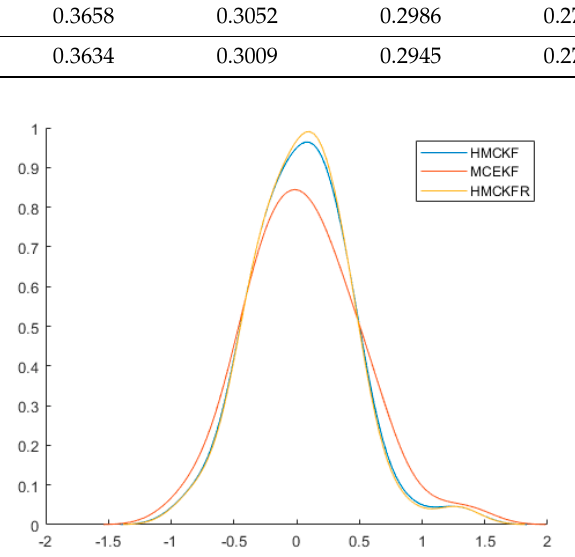
-6 5 σ= ,ε=10 in case 1; ( c , d ) set parameters: